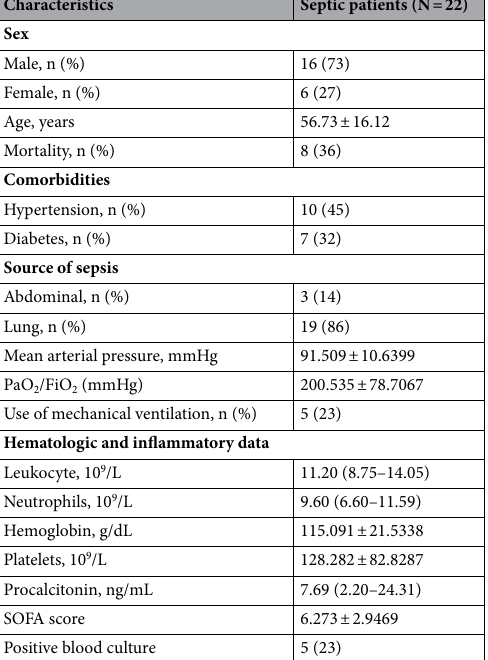
Table 1. Demographic characteristics of septic patients. Data are expressed as number (%), mean ± SD, or median (25th–75th